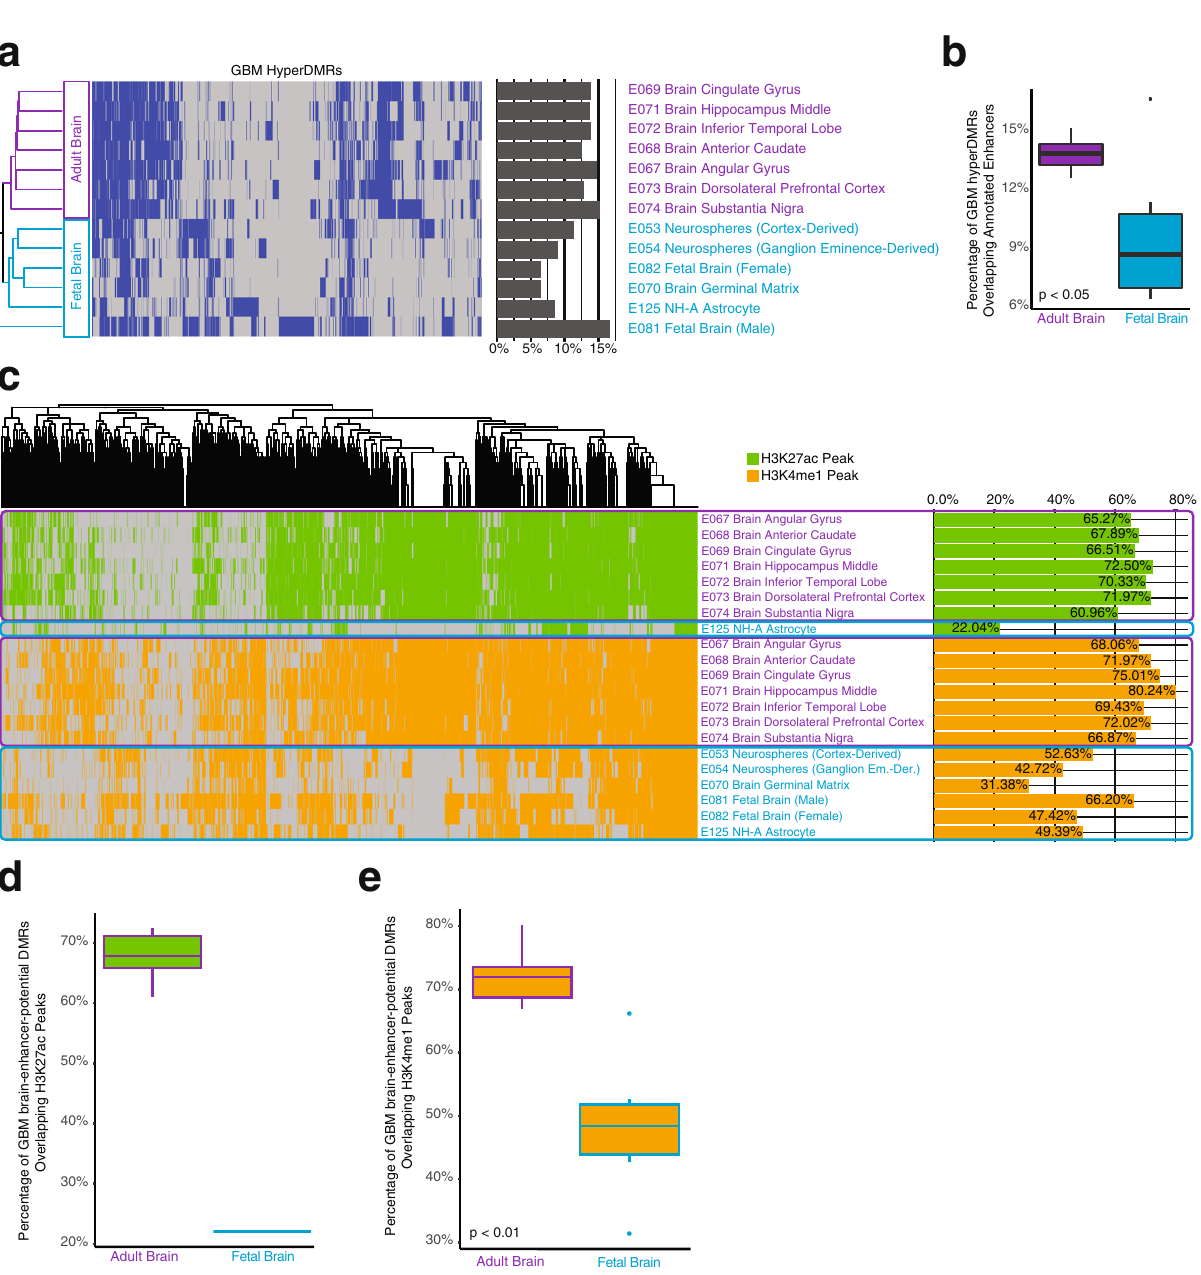
Fig. 5 GBM hyperDMRs possess enhancer chromatin marks in adult brain tissues. a Enhancer annotation (chromHMM 15-state model annotation “ 7_Enh ” 32 ) presence or absence in GBM hyperDMRs in fetal ( n = 6, light blue) and adult brain ( n = 7, purple) tissue/cells 32 (heatmap colors: blue: enhancer annotation present in DMR; gray: enhancer annotation absent in DMR). Bar plot indicates the fraction of all GBM hyperDMRs overlapping enhancer annotations in each cell/tissue type. b Boxplot depicting the distribution of fractions of GBM hyperDMRs overlapping enhancer annotations, comparing adult ( n = 7) and fetal ( n = 6) brain tissues ( t -test, p < 0.05). c H3K27ac (green) and H3K4me1 (orange) peak occupancy within GBM enhancer-potential hyperDMRs (GBM hyperDMRs overlapping an enhancer annotation in at least one adult or fetal brain tissue) across fetal ( n = 1 and 6, for H3K27ac and H3K4me1, respectively, light blue) and adult ( n = 7 for both H3K27ac and H3K4me1, purple) brain tissues. Bar plot indicates the fraction of all GBM enhancer-potential hyperDMRs that contained H3K27ac peaks or H3K4me1 peaks in each cell/tissue type. d Boxplot depicting fractions of GBM enhancer-potential hyperDMRs overlapping H3K27ac peaks in adult brain tissues ( n = 7, left) and horizontal line depicting the fraction of GBM enhancer- potential hyperDMRs overlapping H3K27ac peaks in fetal brain ( n = 1, right). e Comparison of the proportions of GBM enhancer-potential hyperDMRs overlapping H3K4me1 peaks in adult brain tissues ( n = 7, left) to the proportions of GBM enhancer-potential hyperDMRs overlapping H3K4me1 peaks in fetal brain tissues ( n = 6, right) ( t -test, p <